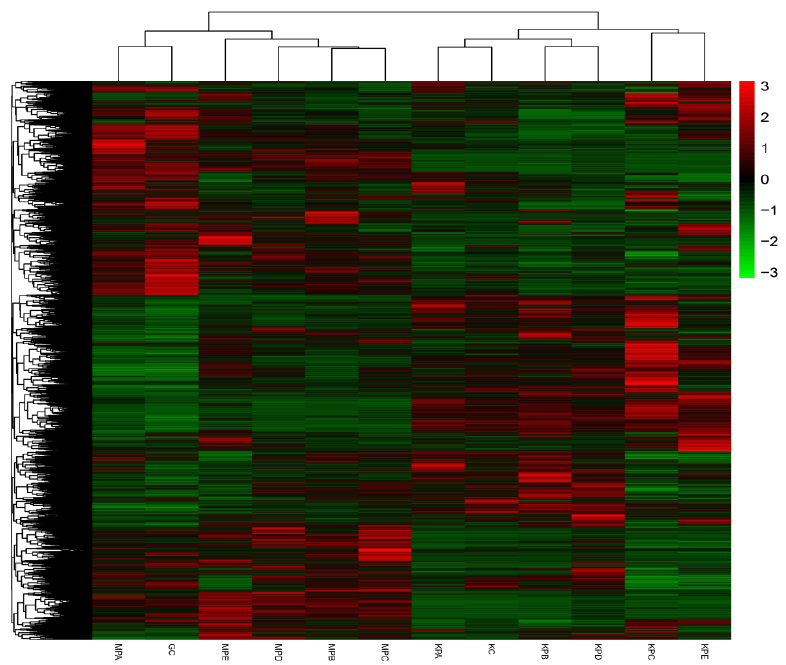
Figure 4. ( a ) Pearson correlation analysis of RNA-seq data from in HZ2399 and SQ25; ( b ) principal component analysis (PCA) plot showing clustering of transcriptomes of six time points after inoculation in HZ2399 and SQ25.